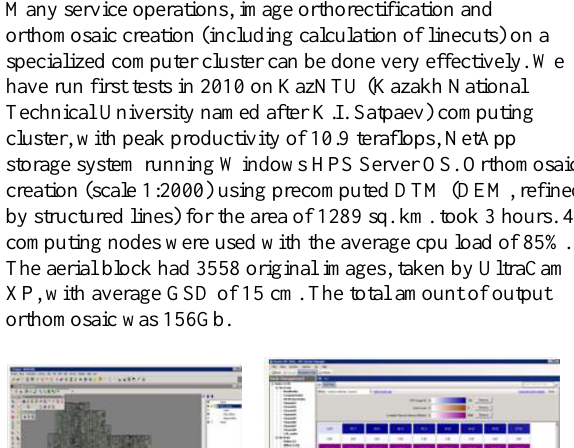
Figure 3. Cluster environment: one workstation and multiple servers